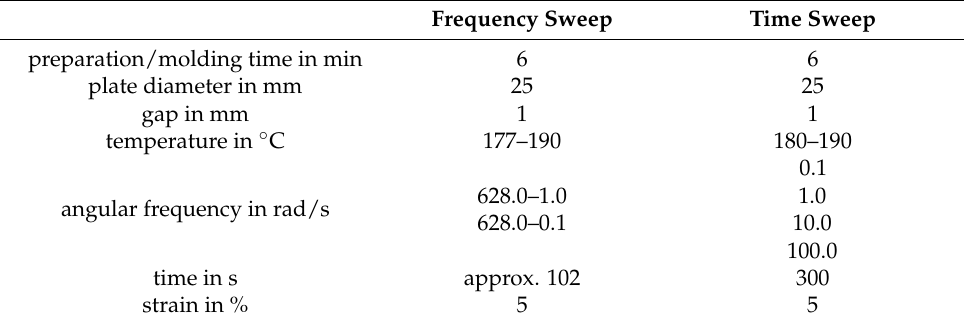
Table 1. Measurement parameters of the rheological measurements. Frequency Sweep Time Sweep preparation/molding time in min 6 6